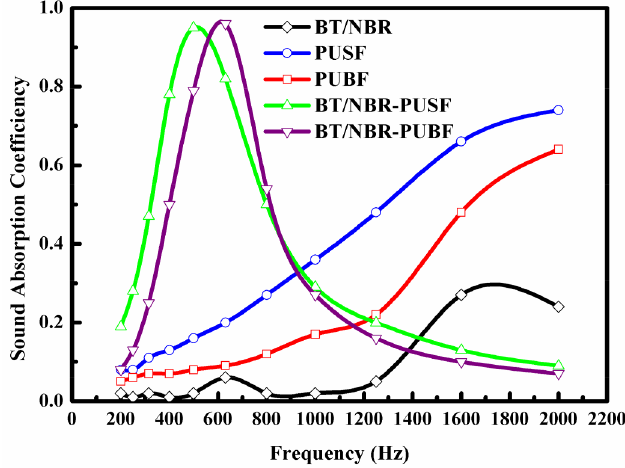
Figure 5. Sound absorption efficiencies of BT/NBR, PUSF, PUBF, BT/NBR-PUSF ( n = 1), and BT/NBR-PUBF ( n = 1)